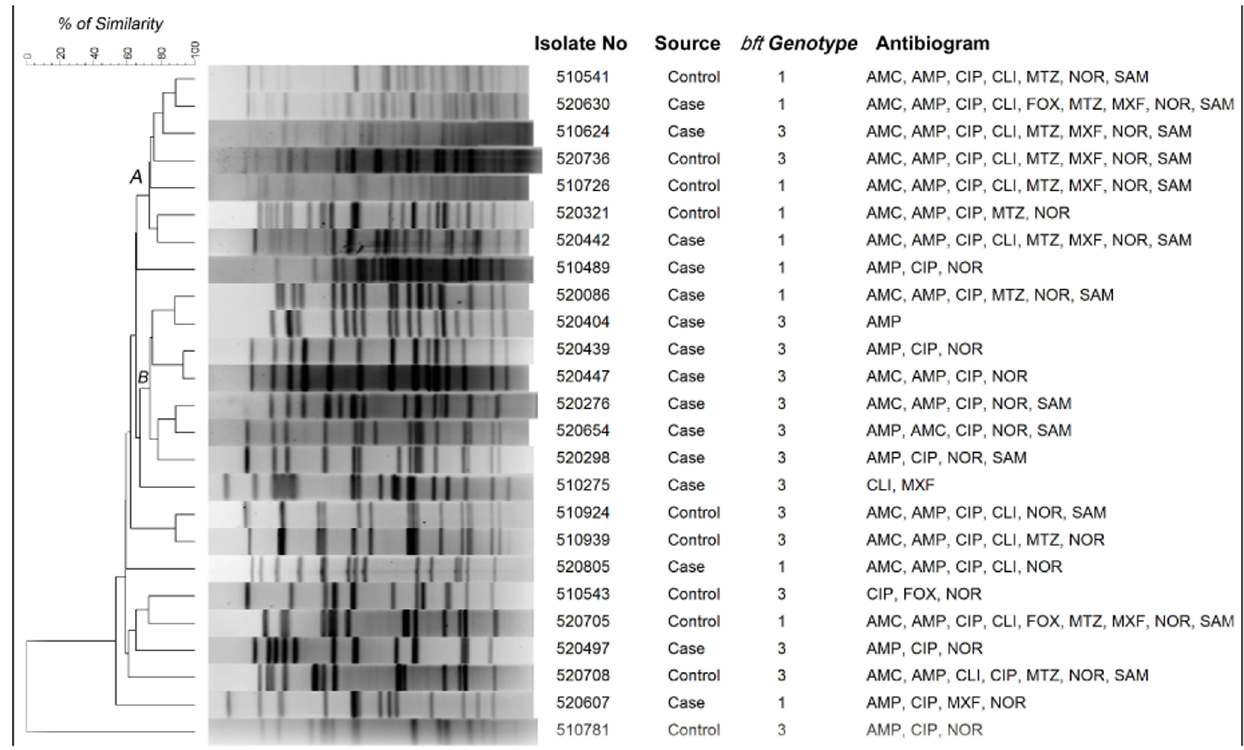
Figure 1. Not1 restriction patterns of genomic DNA of enterotoxigenic B.fragilis isolates. The dendrogram was generated by using UPGAMA method.